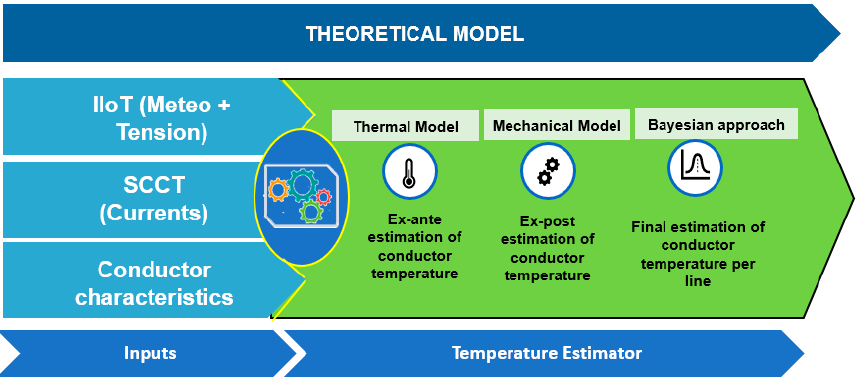
Figure 4 . Theoretical temperature model.